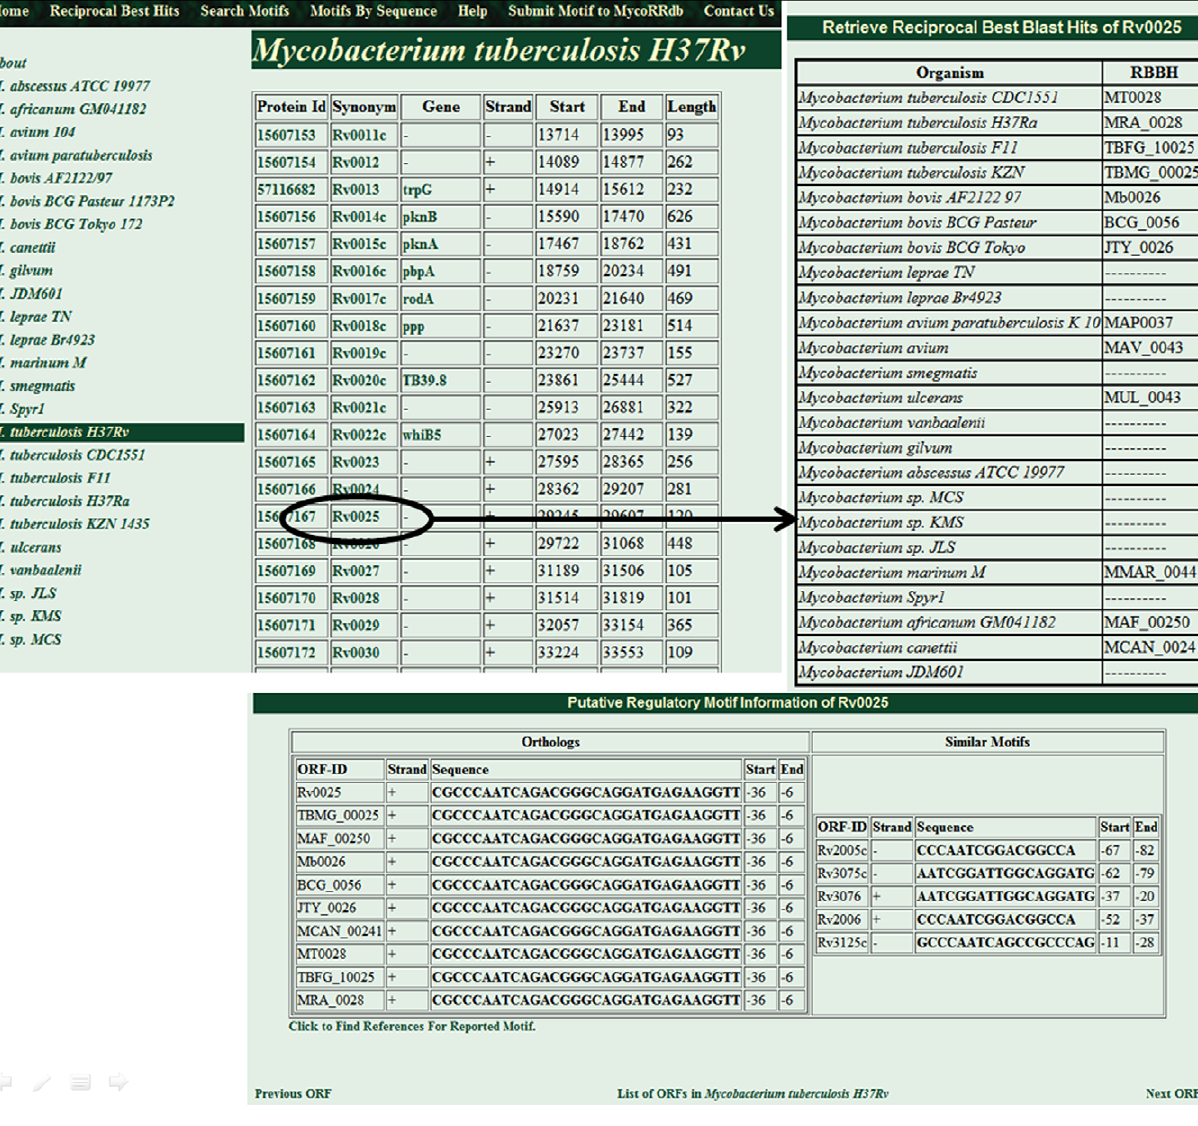
Figure 3. A browsable interface to retrieve RBBHS and DNA motifs.